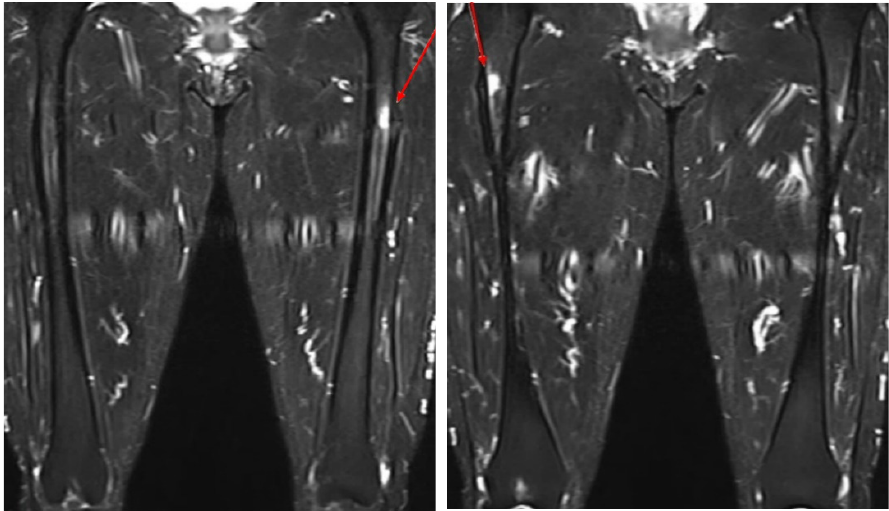
Figure 3. T2 MRI of both hips.. The red arrow shows an impending AFF pattern.